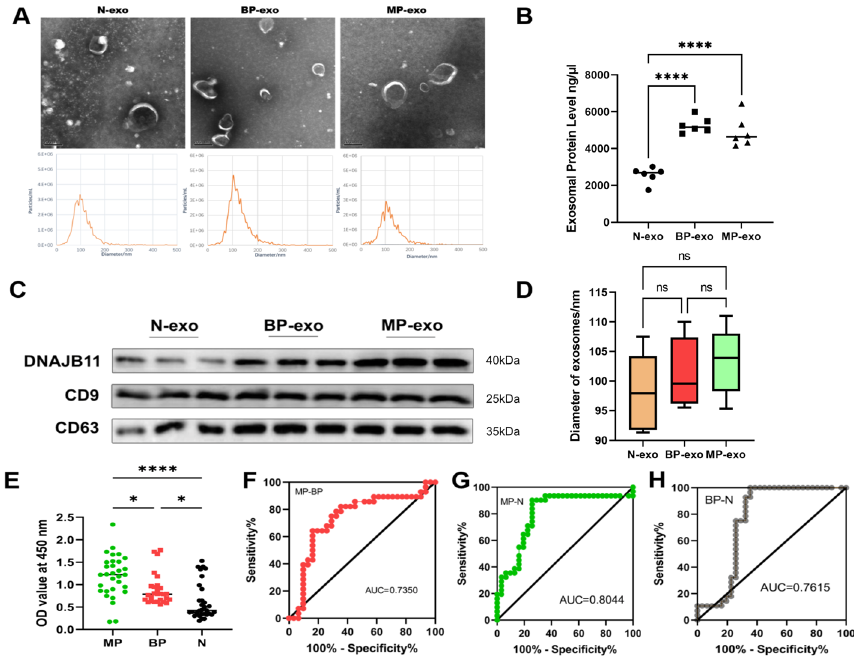
Fig. 1 Exosomal DNAJB11 is a novel diagnostic biomarker for pancreatic cancer. A TEM and NTA of exosomes from healthy people (N-exo), patients with benign pancreatic disease (BP-exo), and patients with malignant pancreatic cancer (MP-exo) are shown. B Protein levels of N-exo, BP-exo, and MP-exo. ( n Western blot validation of exosomal markers (CD9 and CD63) and DNAJB11 of N-exo, BP-exo, and PC-exo ( n 6 per group). D No significant difference between the sizes of N-exo, BP-exo, and PC-exo ( n = group). E Exosomal DNAJB11 level distribution in clinical plasma samples. F ROC curve analysis of exosomal DNAJB11 between MP-exo and BP-exo groups. G ROC curve analysis of exosomal DNAJB11 between MP-exo and N-exo groups. H ROC curve analysis of exosomal DNAJB11 between BP-exo and N-exo groups. * P < 0.05, ** P < 0.01, *** P < 0.001, **** P < 0.0001, one-way ANOVA. The values are shown as mean mean